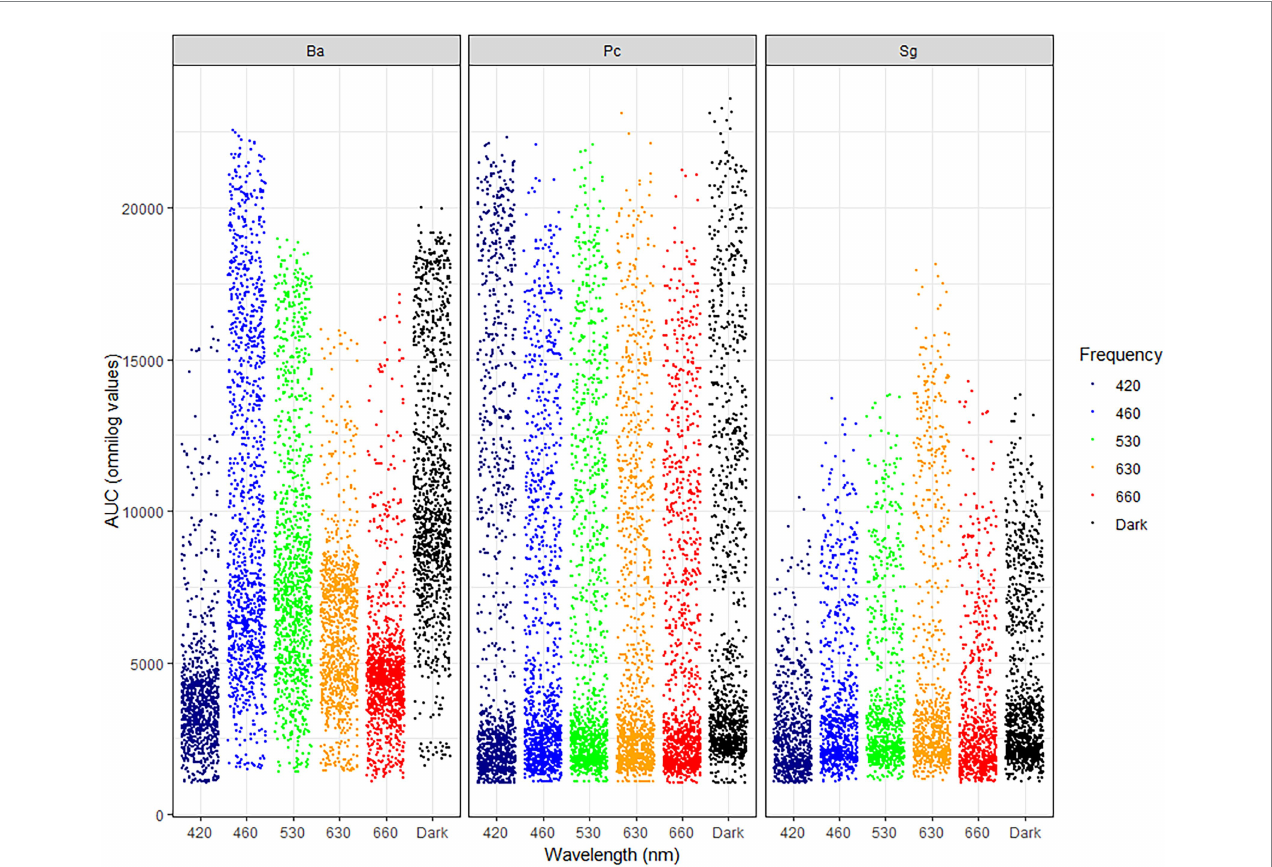
FIGURE 1 Jitter plot showing the area under the curve (AUC) for utilization of 190 sole carbon sources under different wavelengths (420, 460, 530, 630, and 660 nm) and in dark conditions by Bacillus amyloliquefaciens (BA), Pseudomonas chlororaphis (PC), and Streptomyces griseoviridis (SG). Each dot represents maximum Omnilog value of each single carbon